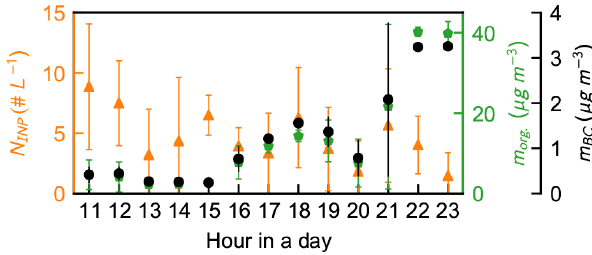
Figure 9. Mass concentration of organics ( m org . ) and BC ( m BC ) on clean